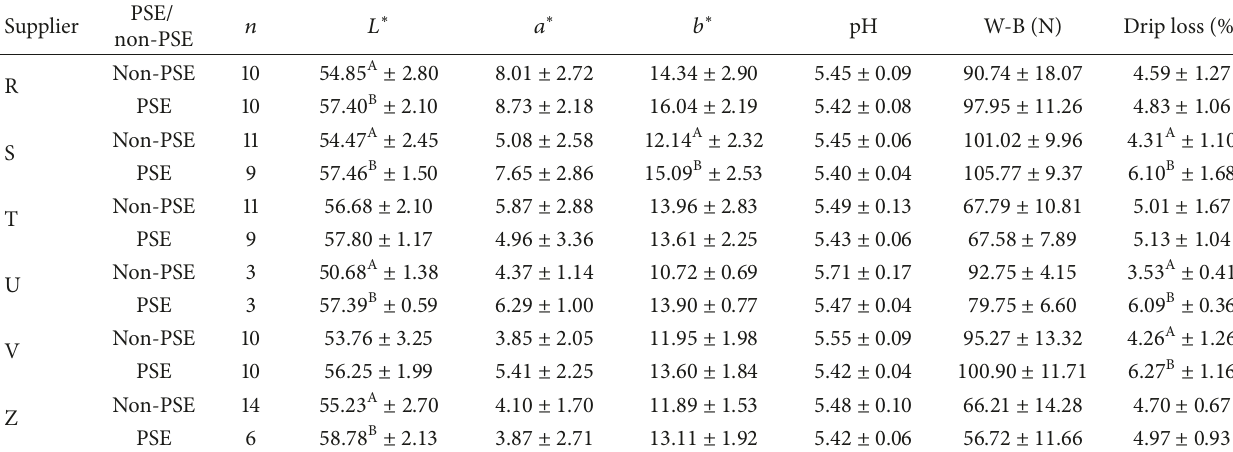
𝐿 ∗ : lightness, 𝑎 ∗ : redness, 𝑏 ∗ : yellowness, and W-B: Warner-Bratzler test-maximum shear force. A , B Different letters in the same suppliers show statistically significant differences between non-PSE and PSE ( 𝑃 < 0.05